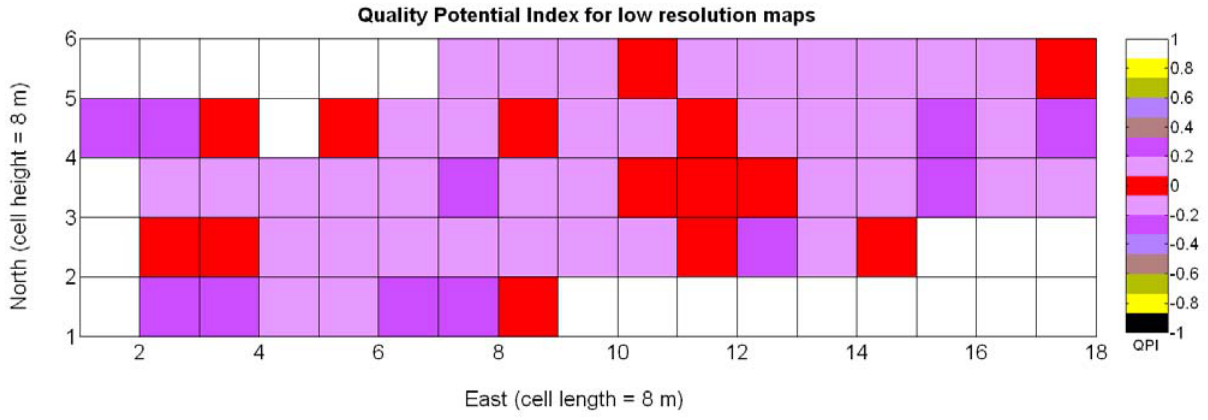
Figure 31. Low resolution CB map for the Quality Potential Index QPI.